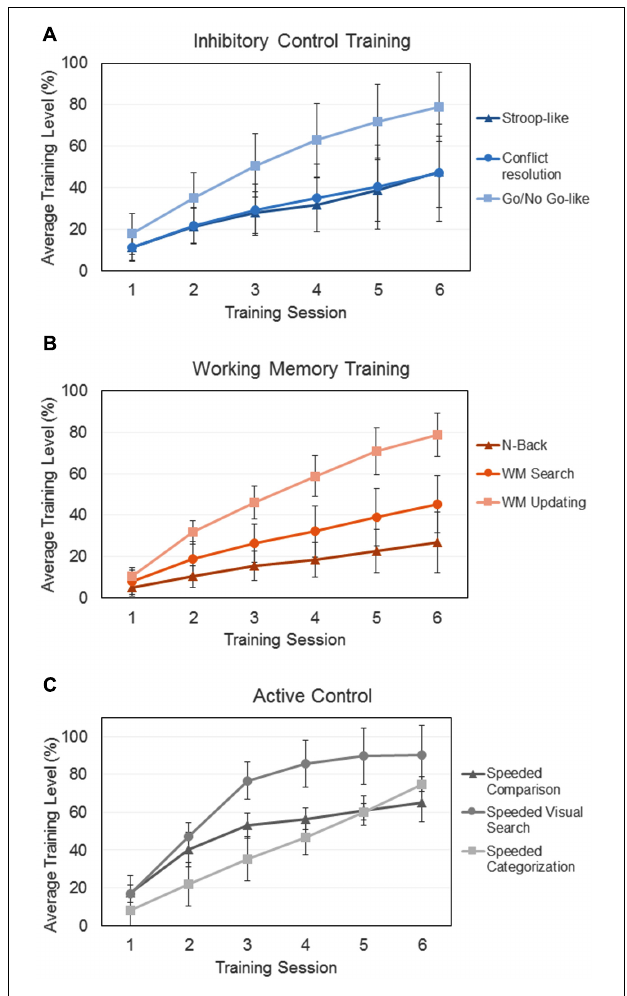
FIGURE 1 | Training improvement over the six training sessions for the three different groups that complete training procedures: (A) Inhibitory Control Training, (B) Working Memory Training, (C) Active Control. In all the cases, y -axes represent the average relative level achieved in each session and training activity. Error bars represent standard